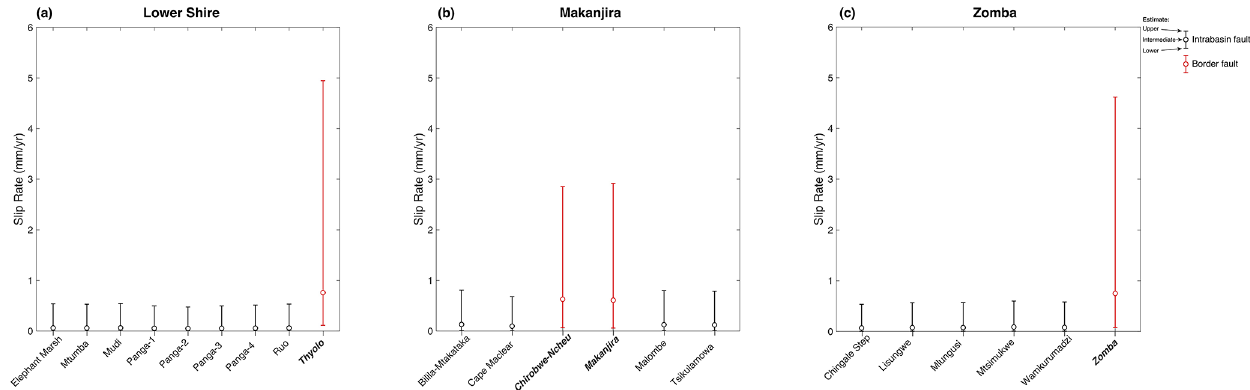
Figure 9. Fault slip rate estimates in the SMSSD, calculated following the approach outlined in Fig. 6 and sorted into different basins in southern